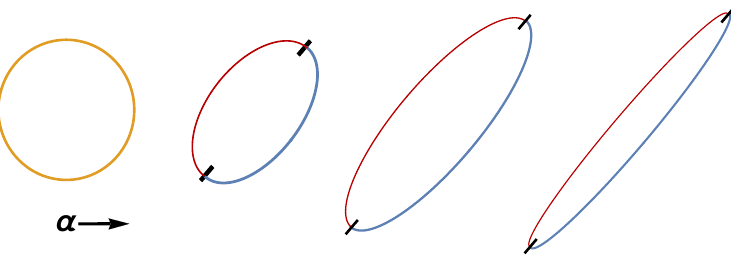
Figure 4 . Illustration of how acclereation affects the string shape. As the acceleration increases from zero, the string “folds” at the special points and gradually gets more and more elongated. One can think of the special points as boundary of two ‘open’